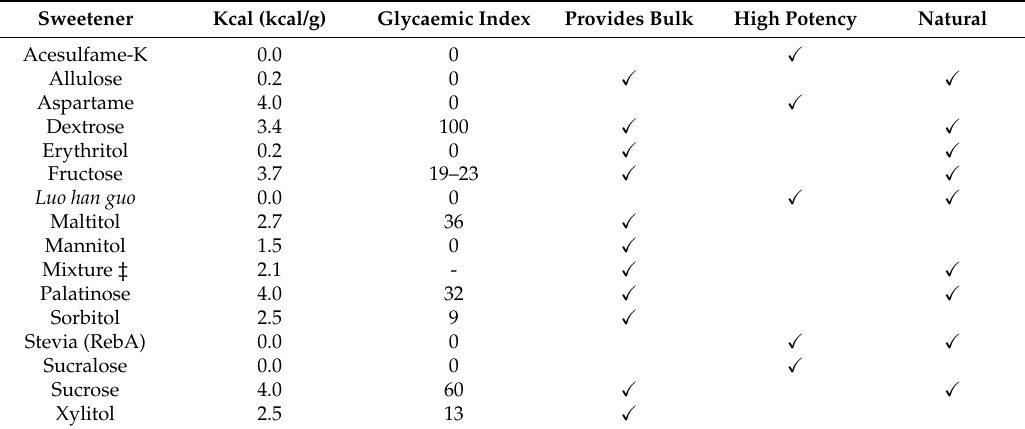
Table 1. Characteristics of the 16 sweeteners